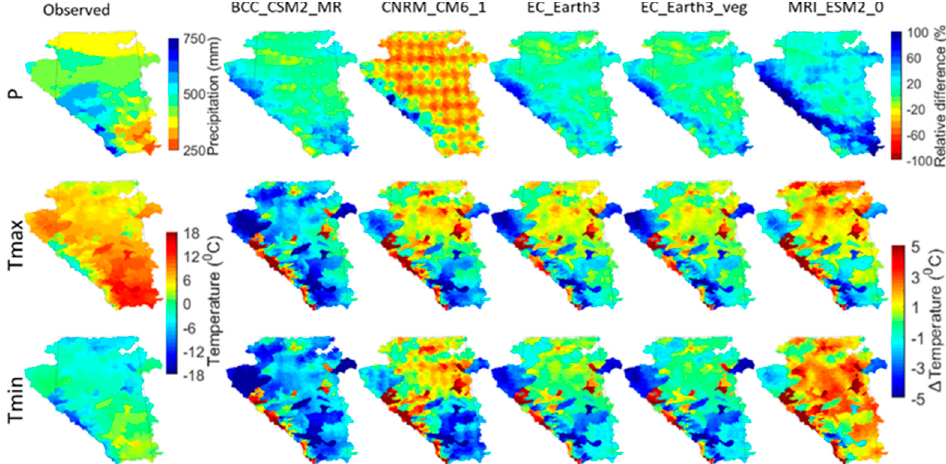
Figure 3. Observed mean annual precipitation (in mm) and mean annual daily temperature (maxi- mum and minimum in °C) for the 1983–2014 period are shown in the first column in the left. Relative difference for precipitation (%) and only difference for temperature (°C) between the GCM simulated and observed data for the same period is shown in right four columns. A positive relative difference and delta temperature indicate an overestimation by GCMs.